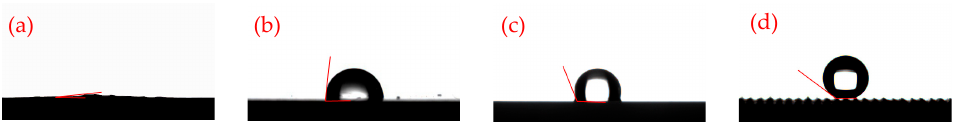
Figure 4. Contact angle characterization of each surface at room temperature, where the volume of the droplet is 2 µL. ( a ) Super hydrophilic surface; ( b ) hydrophilic surface; ( c ) hydrophobic surface; ( d ) superhydrophobic surface.